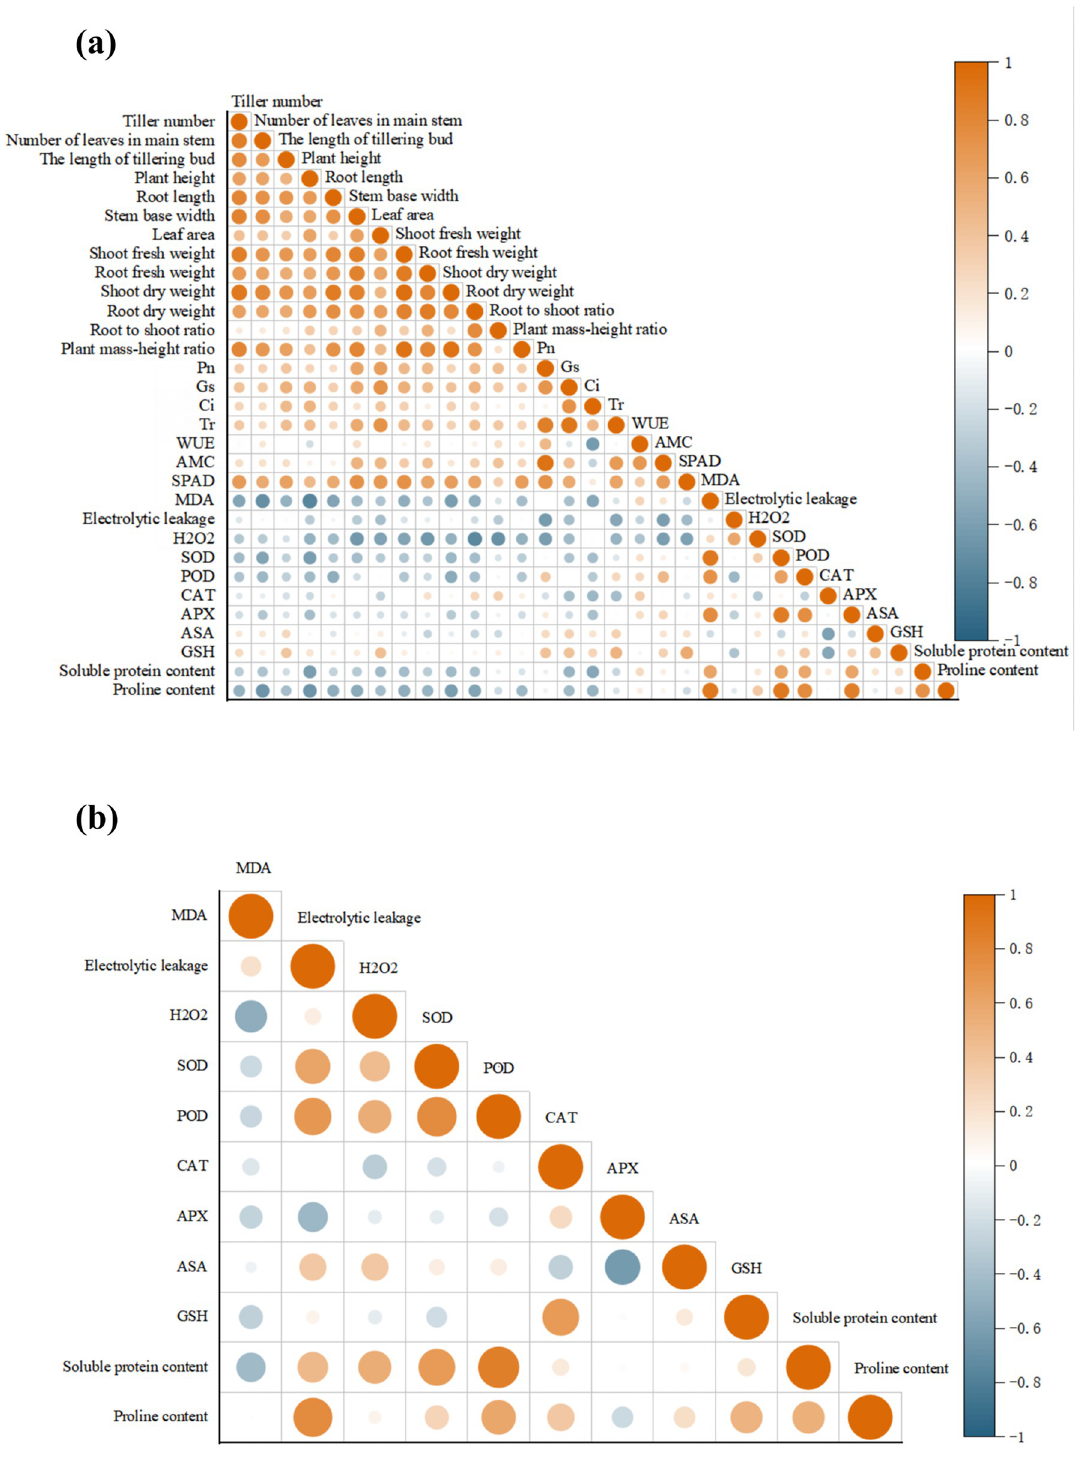
Fig 8. The correlation analysis of tillering ability, photosynthesis, and antioxidant indices in different parts of the rice. The correlation analysis of the rice leaves (a) and roots (b). Significant difference at the level of P < 0.05.